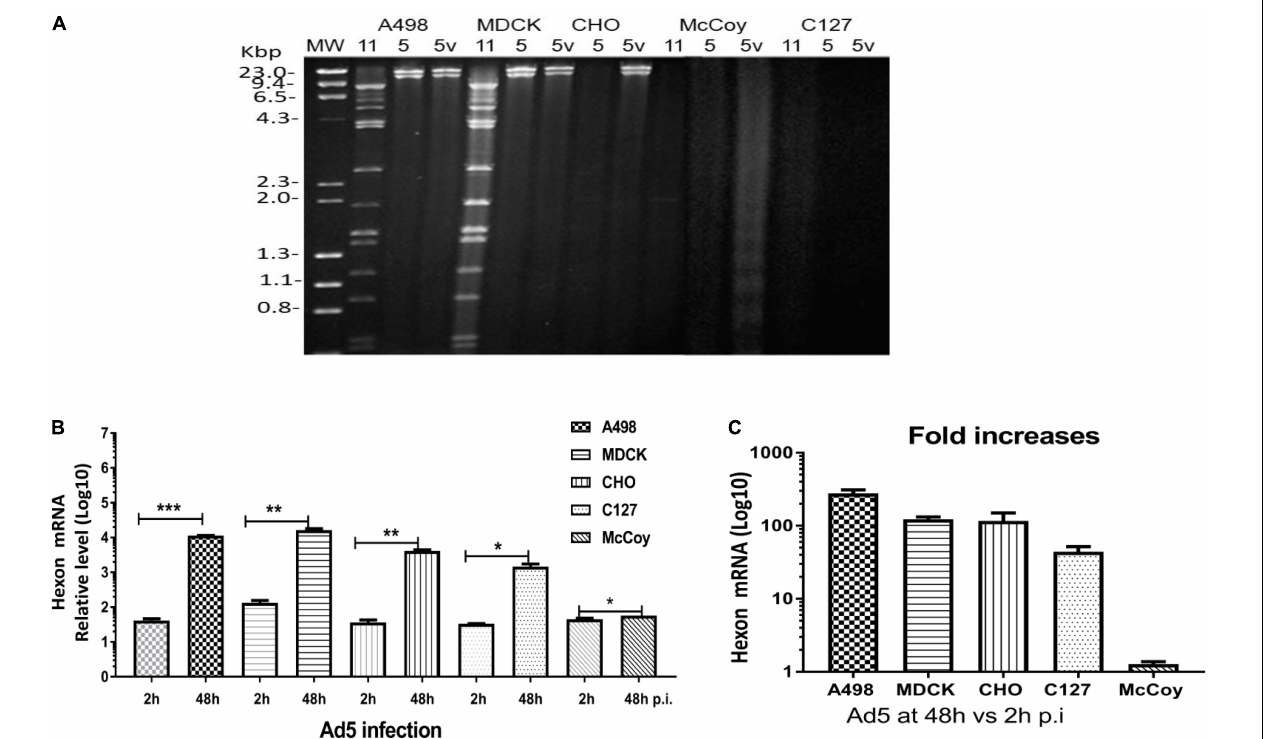
FIGURE 5 | (A) Assessment of Ad11p, Ad5p, and pFG140 viral DNA replication in A498, MDCK, CHO, McCoy, and C127 cell lines. Animal cells (MDCK, CHO, McCoy, and C127) and the control human (A498) cells were infected with Ad11p, Ad5, and pFG140 at 1 pg/cell, as described in section “Materials and Methods.” Viral DNA harvested and purified from the infected cells was digested with the Bam HI restriction endonuclease. Sample list: 11 means Ad11p; 5 means Ad5p; 5v means pFG140 vector. (B) Quantification of Ad5 hexon expression at 48 vs. 2 h.p.i. (C) Fold increases in DNA copies in four animal cell lines and human A549 cells. The asterisks indicate a significant difference, as determined by an unpaired t -test, * p < 0.05; ** p < 0.01; *** p < 0.001. The data are shown as averages ± SEs from three